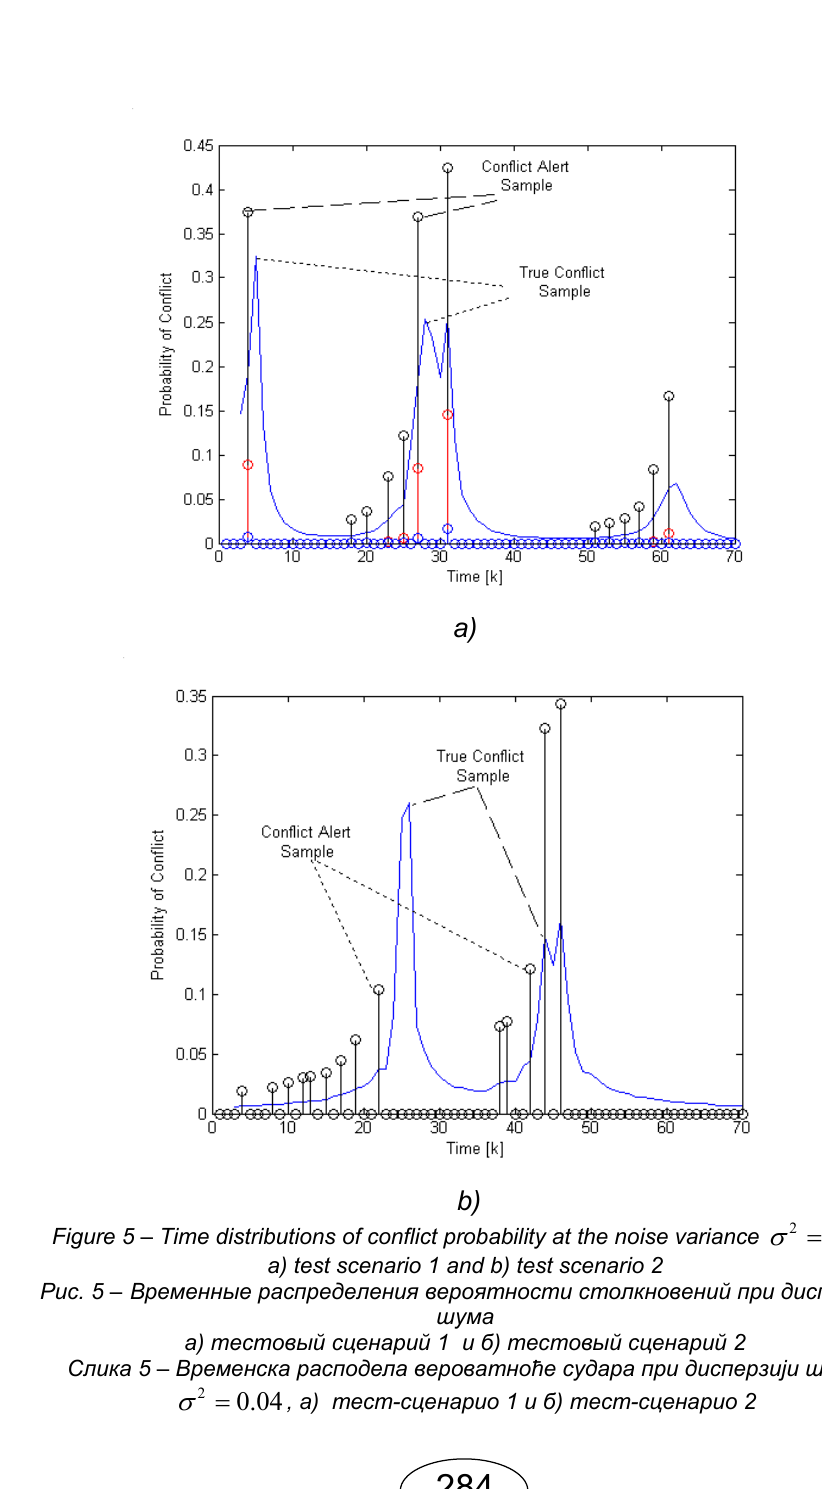
Figure 5 – Time distributions of conflict probability at the noise variance 04.0 2   a) test scenario 1 and b) test scenario